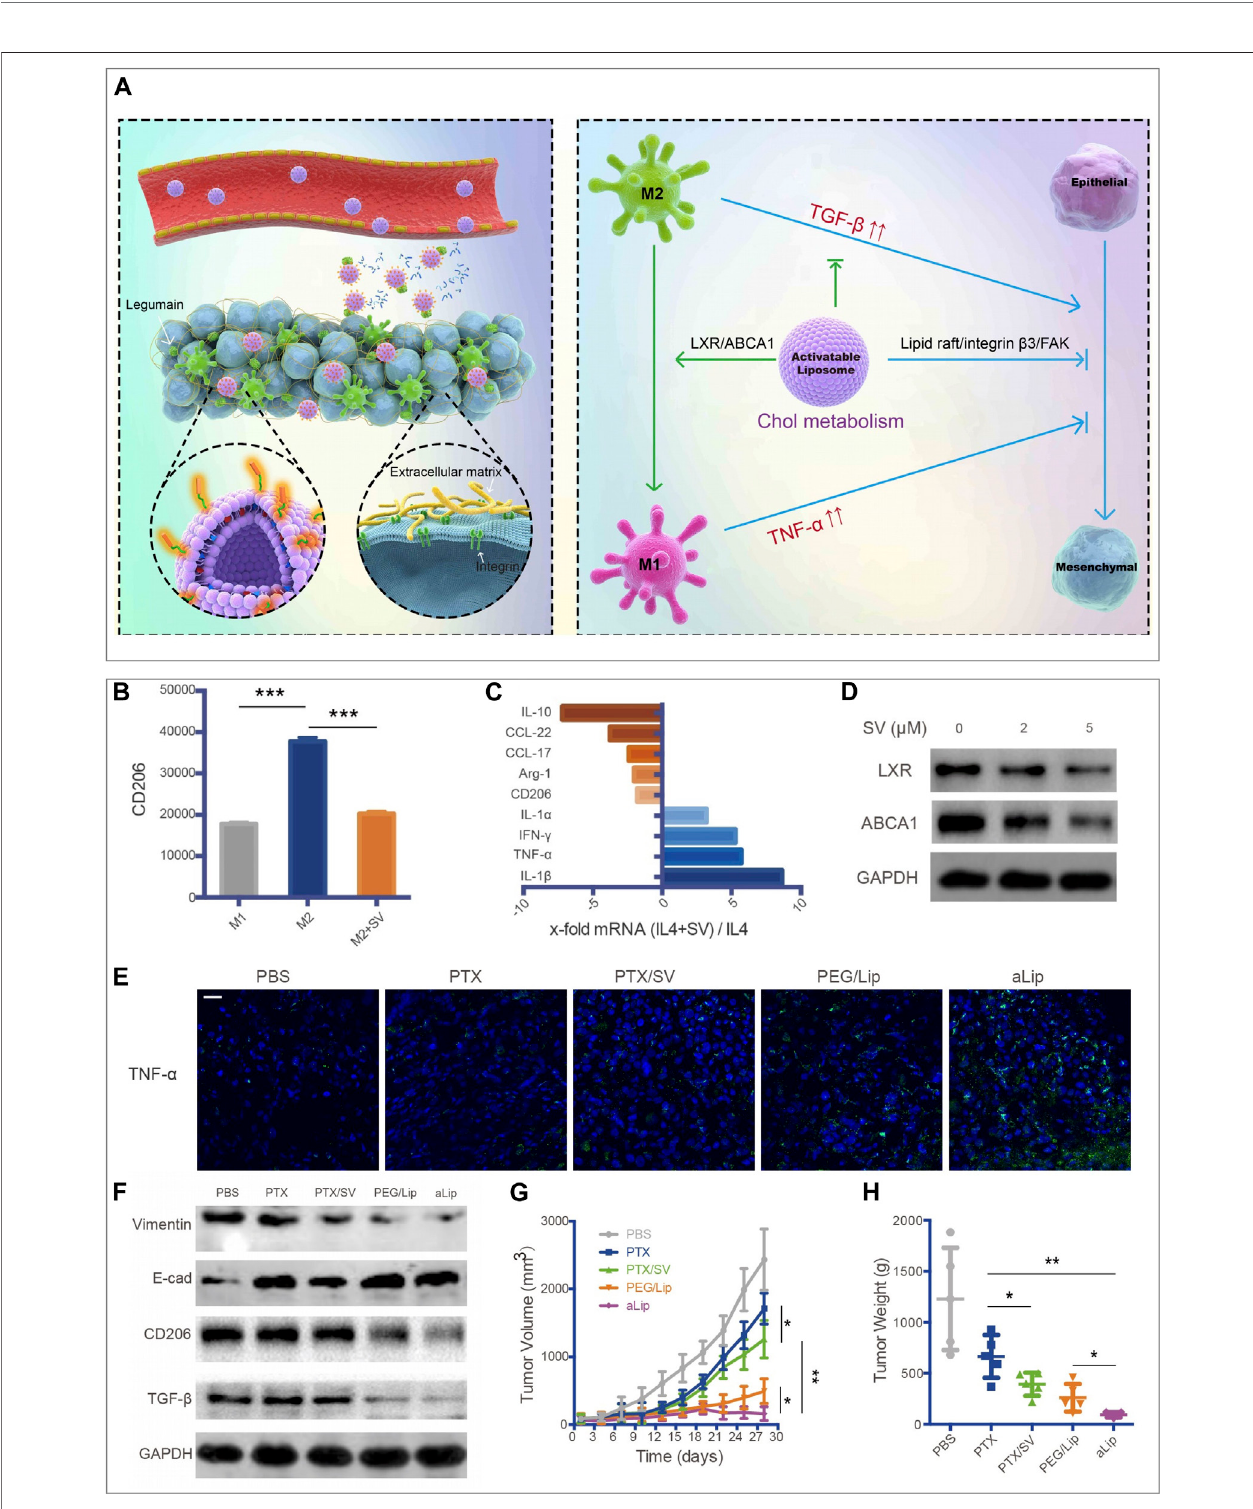
FIGURE 3 | aLip mediated lipid metabolic reprogramming of macrophages for cancer therapy (Jin et al., 2019). (A) The preparation and function of aLip are illustrated.aLipcouldrealizetargeteddrugdeliverybyrespondingtotheoverexpressedlegumainintheTMEandrepolarizeTAMthroughcholesterolmetabolism. (B) SV reduced expressions of CD206 in M2 macrophages. (C) RT-PCR (Reverse Transcription-Polymerase Chain Reaction) detections of M1 and M2 related genes in M2 macrophageswiththetreatmentofSV. (D) SVdownregulatedABCA1andLXRexpressionsinM2 Φ . (E) aLipupregulatedtheexpressionofTNF- α intumortissues. (F) aLip suppressed the expression of CD206 and TGF- β in tumor tissues. (G) aLip inhibited the tumor growth in the subcutaneous A549T-xenograft model. (H) Tumor weight in the endpoint of treatments. Reprinted under the Creative Commons CC BY license.